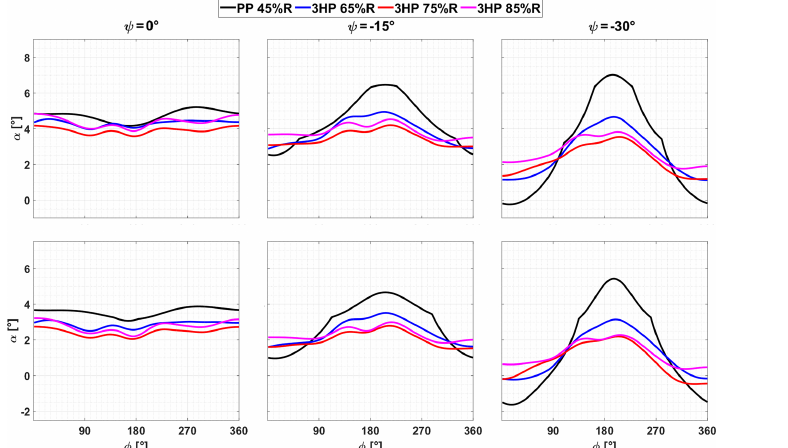
Figure E2. AoA results from the pressure tap and three-hole-probe approaches. In columns are shown the yaw angles: ψ = 0 ◦ , ψ = − 15 ◦ and ψ = − 30 ◦ . In rows are shown the pitch angles: θ = 4 ◦ and θ = 6 ◦